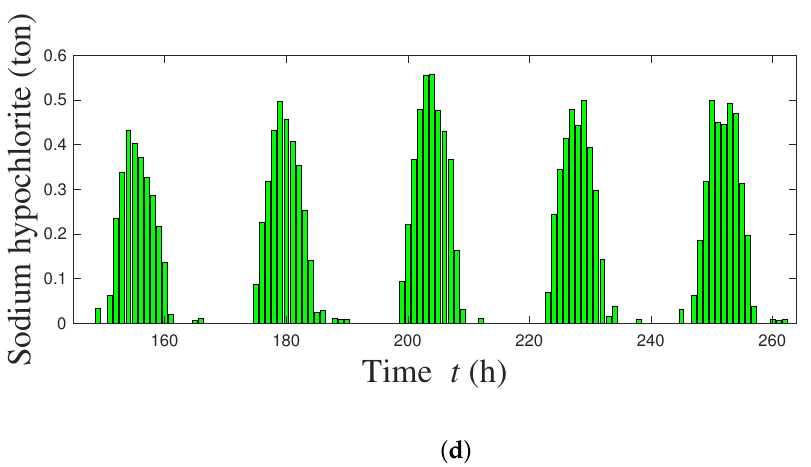
Figure 7. Simulation results of case 4. ( a ) The per hour PV generation. ( b ) The trends of PV power and load demand. ( c ) The simulation results for 5 days. ( d ) The generation of NaOCl in 5